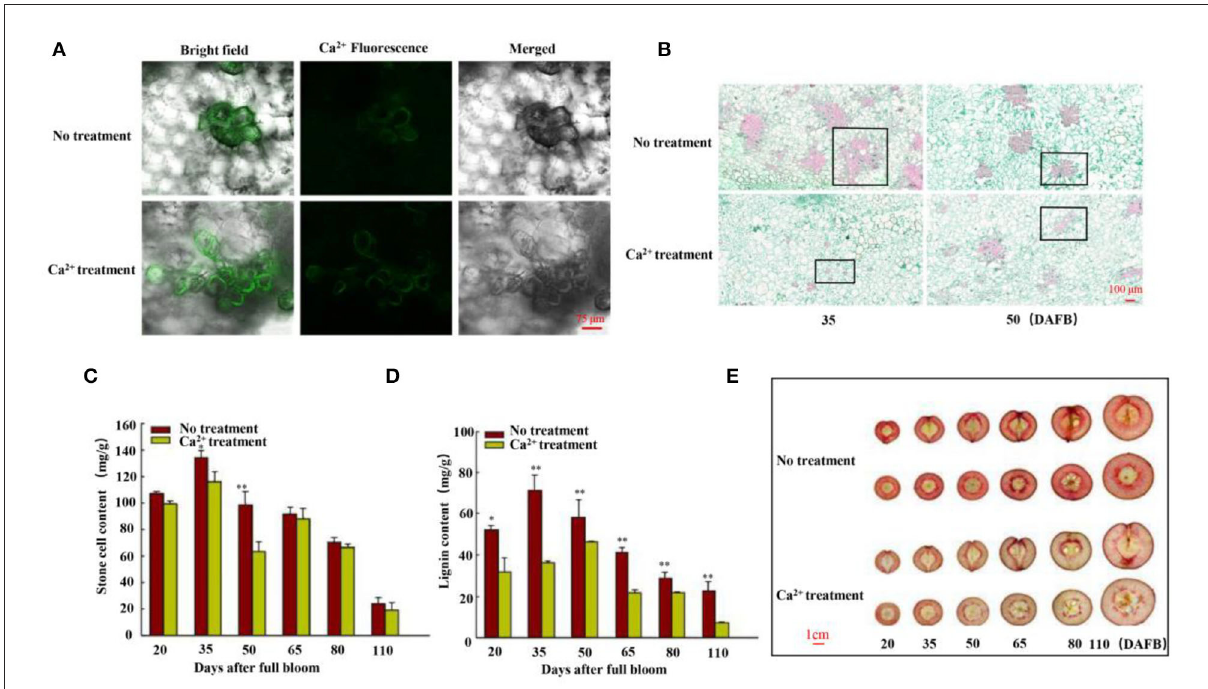
FIGURE1 Free Ca 2 + , stone cell morphology, and lignin and stone cell contents. (A) Free Ca 2 + in the flesh cells of fruits was detected using Fluo-3/AM 35 days after full bloom (DAFB). Scale bar 75 µ m. (B) Morphology of stone cells was observed using paraffin sections of fruits 35 and 50 DAFB. Scale bar 100 µ m. (C) Stone cell production and (D) lignin content of fruits were measured at six stages (20, 35, 50, 65, 80, and 110 DAFB). (E) Staining of sections with phloroglucinol-HCl (scale bar 1cm). Data are shown as means ± SE (n = 3). Statistical significance was determined by Student’s t -test: ** P <